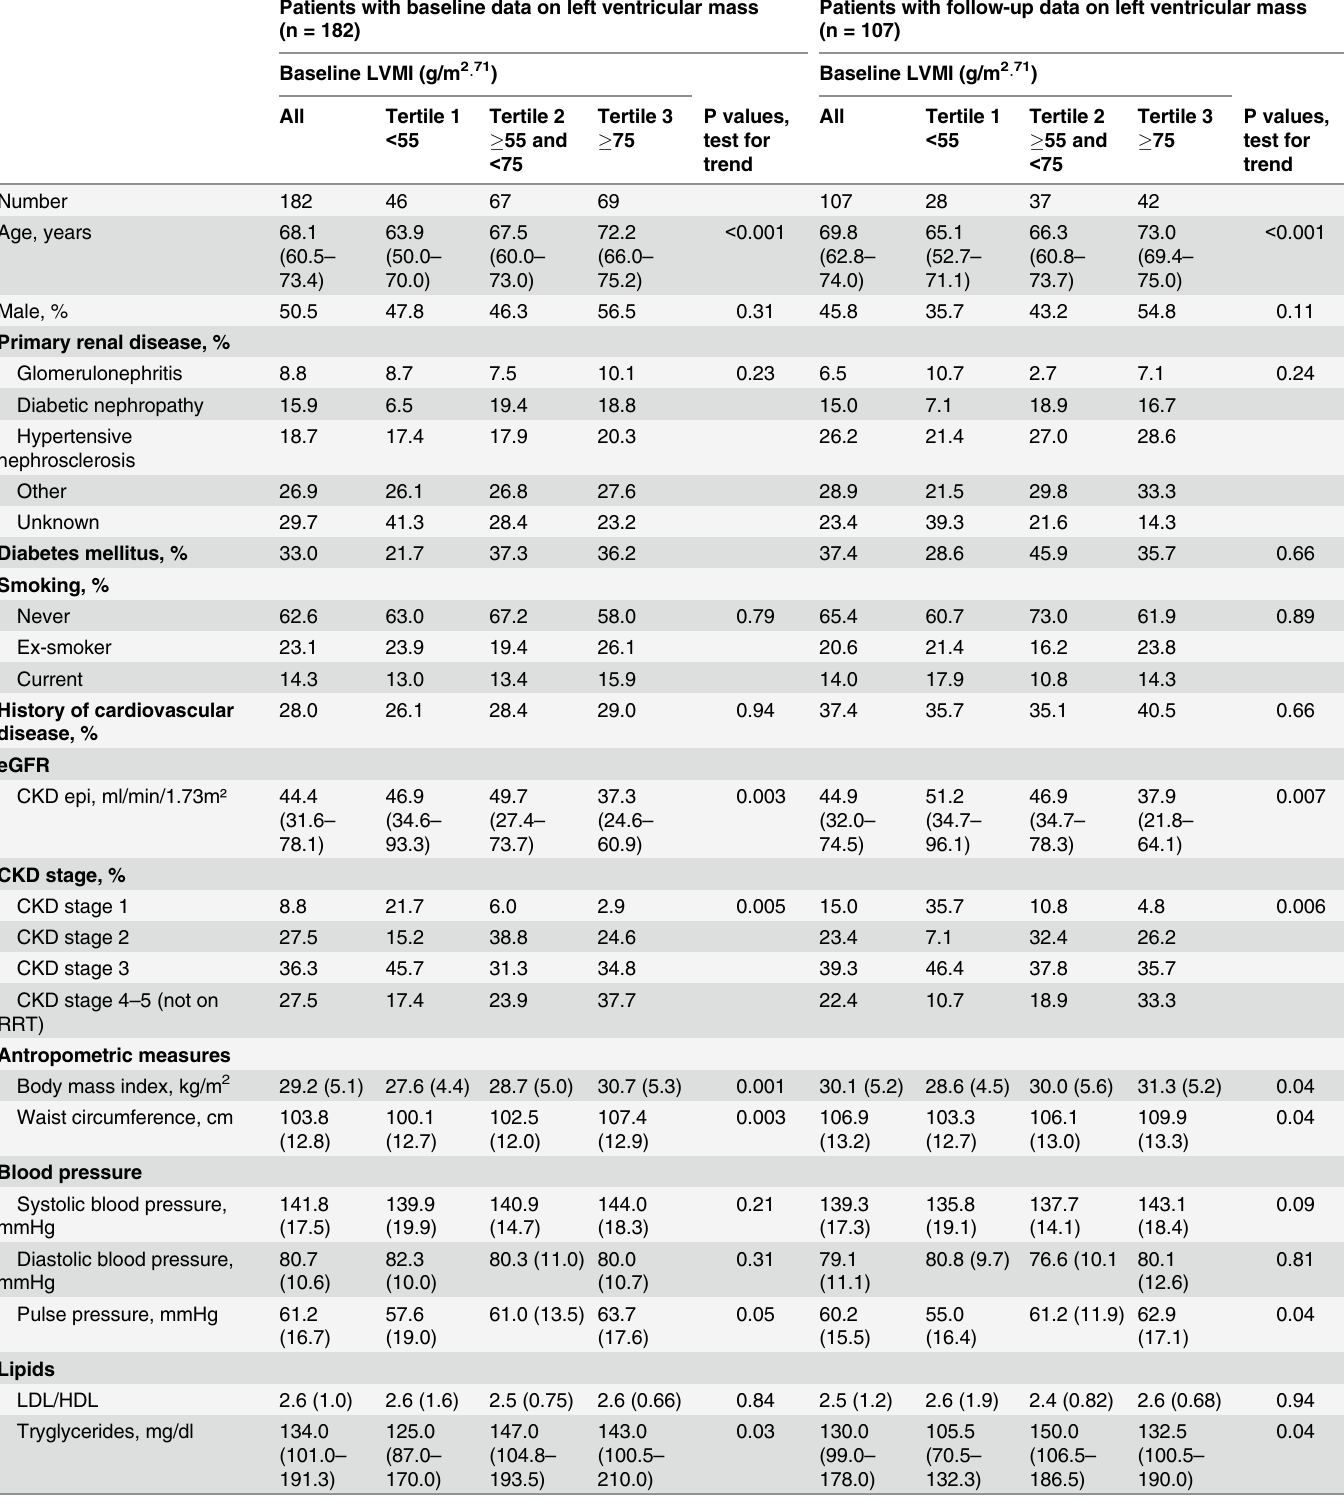
Patients with follow-up data on left ventricular mass (n = 107)